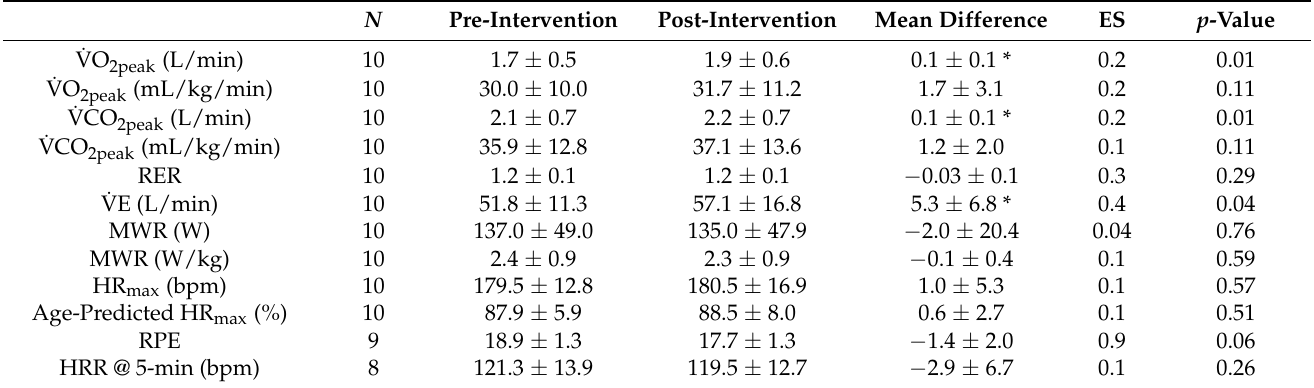
Table 6. Cycle ergometer ˙VO 2peak test metric pre-post